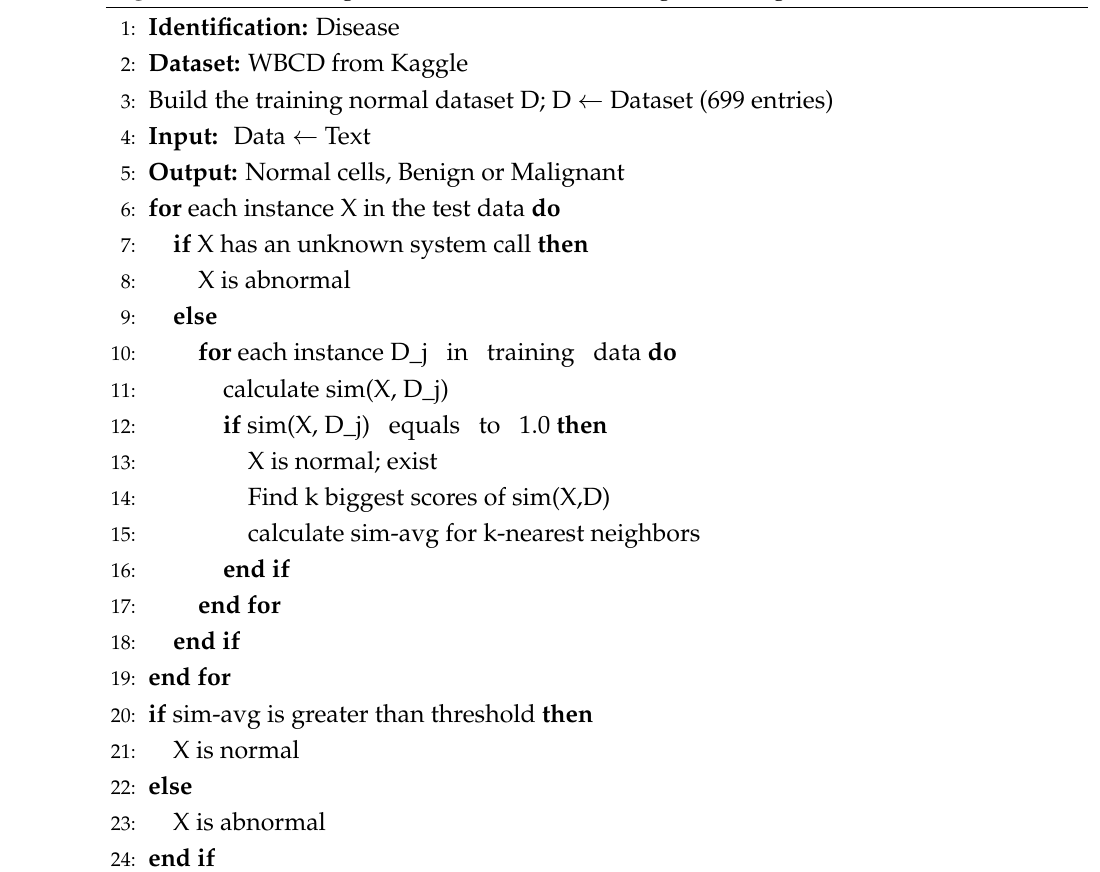
Algorithm 1 KNN Algorithm to Differentiate Benign or Malignant